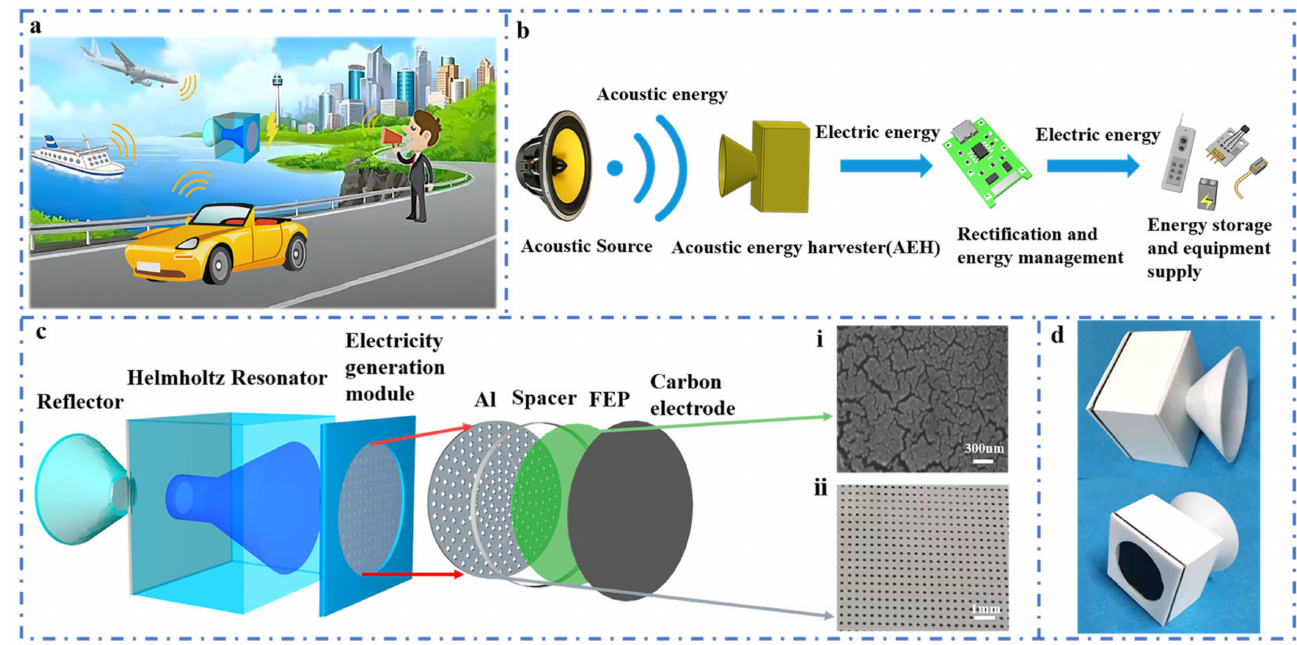
Figure 1. The structure design of the CHR-TENG. ( a ) Schematic diagram of various applications of the CHR-TENG in acous- tic energy harvesting. ( b ) Schematic diagram of the acoustic energy harvesting and management system. ( c ) A schematic illustration of the CHR-TENG. ( d ) Physical images of the